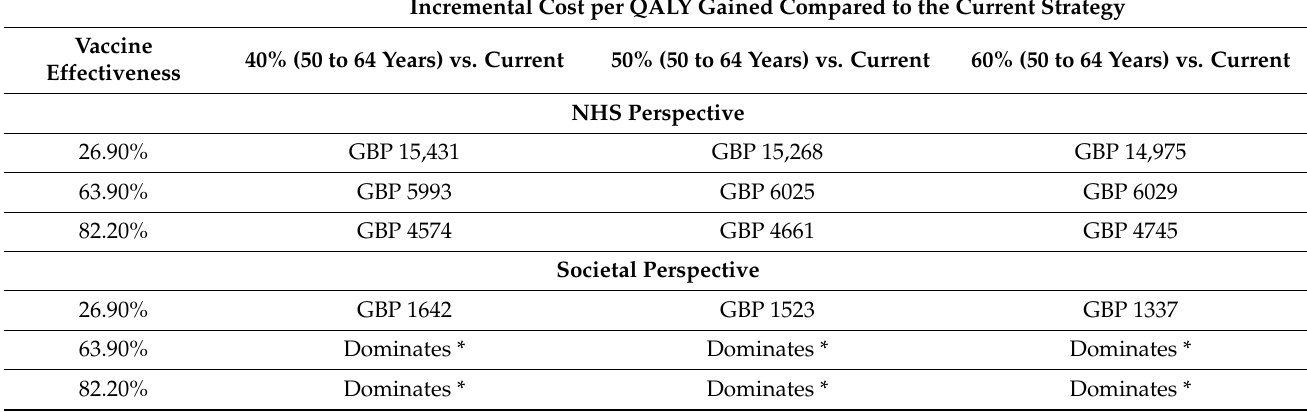
Table 5. The incremental cost per quality-adjusted life-year ratio associated with vaccinating low risk individuals ages 50- to 64-year-olds across various coverage and vaccine effectiveness